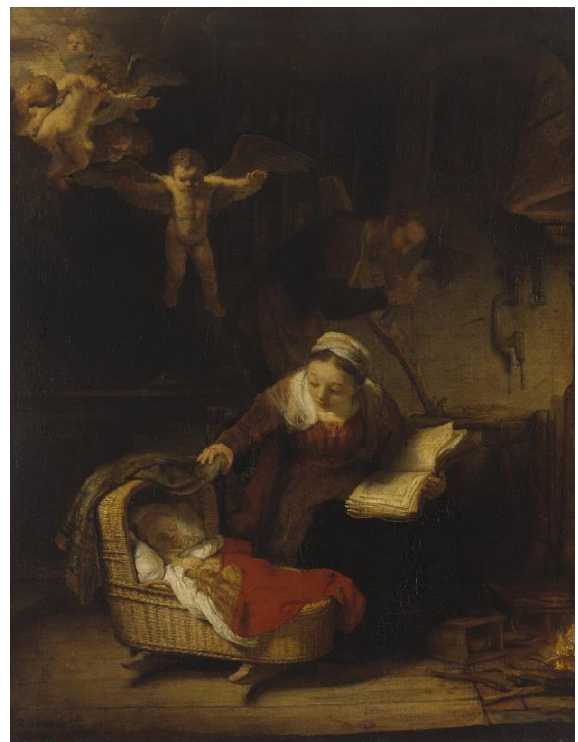
Figure 8. Rembrandt, The Holy Family with Angels , 1645, 117 cm (46 in) × 91 cm (36 in), Hermitage Museum.